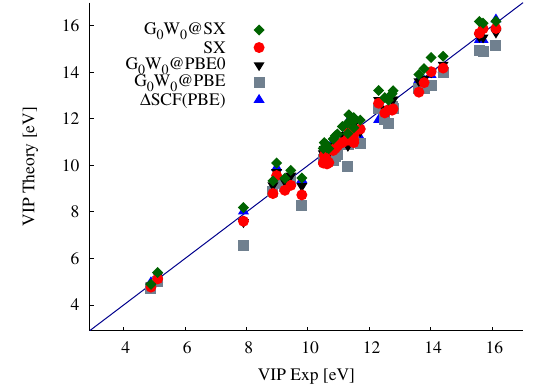
FIG. 1. Vertical ionization potentials (VIP) of the G 2 = 97 subset consisting of 36 closed-shell molecules computed as the highest occupied molecular orbital energy using the SX hybrid functional (SX), G 0 W 0 starting from PBE wave functions (G 0 W 0 @ PBE; data from Ref. [56]) and SX wave functions (G 0 W 0 @ SX), and total energy differences [ Δ SCF ð PBE Þ ; data from Ref. [62]].